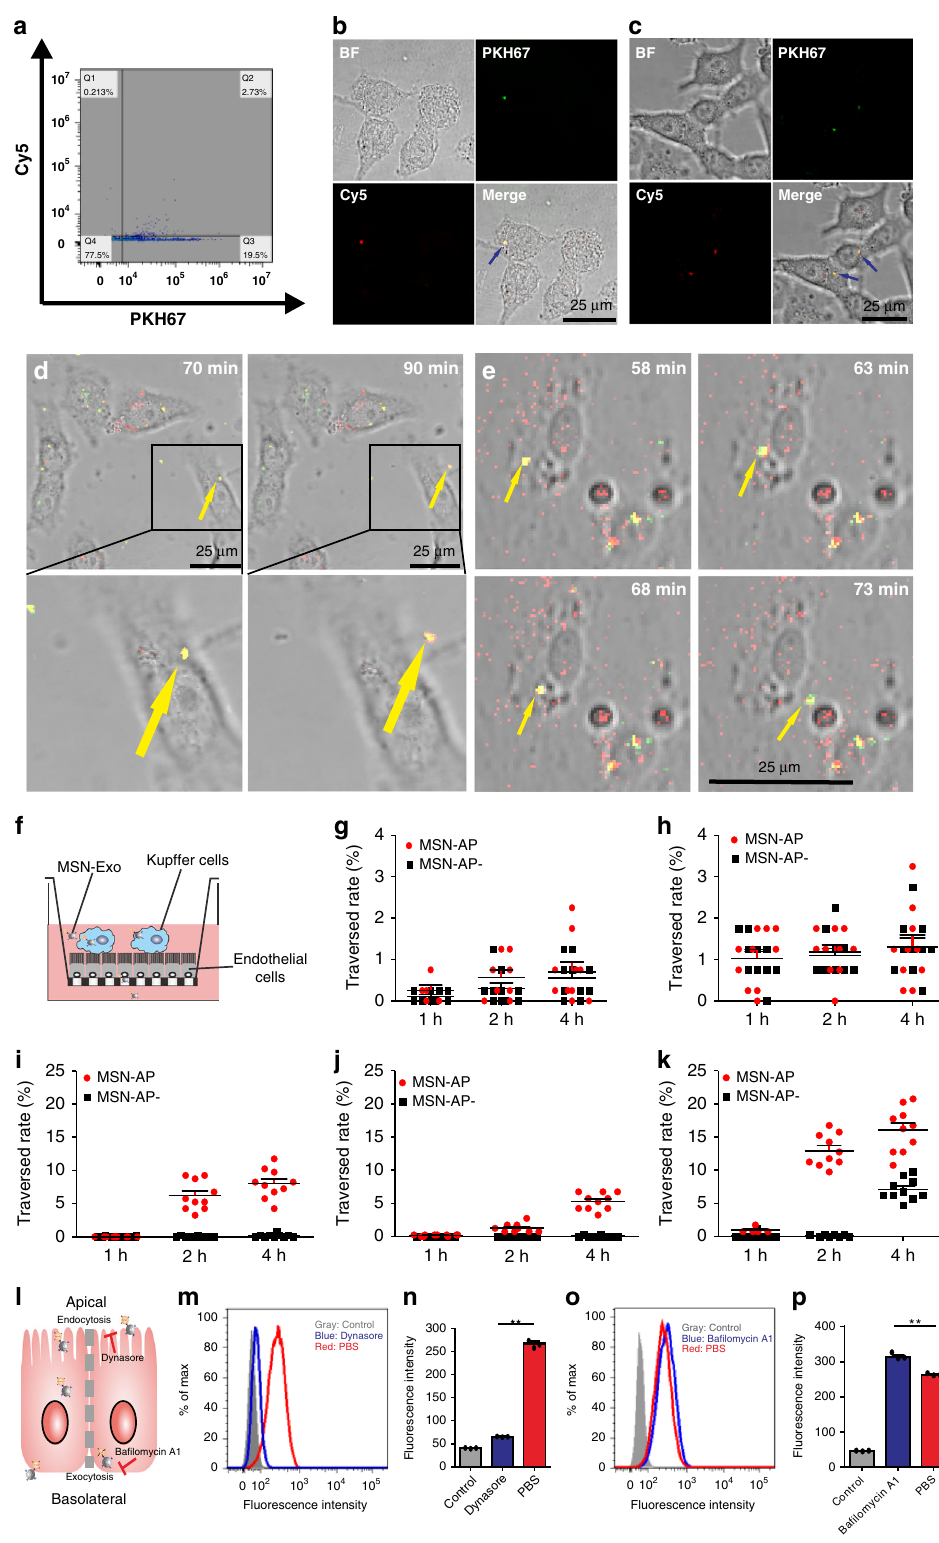
vein followed by the local injection of MSN-AP (5 mg per kg) to bind A-Exo and collected the duodenum contents from the rats 10 min later. We used the qRT-PCR method to quantify the DNA-transfected A-Exo content (Fig. 1a; Supplementary Fig. 23) in the duodenum after the injection, and found that MSN-AP signi fi cantly enhanced the amount of A-Exo accumulated in the NATURE COMMUNICATIONS| (2019) 10:5476